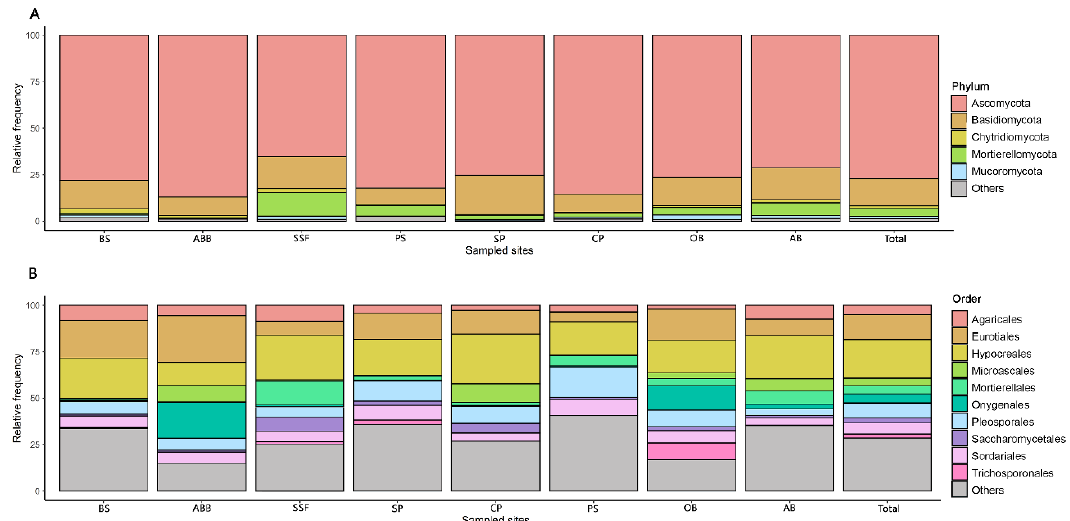
Figure 2. Relative frequency of phylum ( A ) and the ten most abundant orders ( B ) in different environments. BS = Brazilian savanna; ABB = abandoned rural building; SSF = seasonal semi-deciduous forest; PS = pasture; SP = sugarcane plantation; CF = coffee plantation; OB = owls’ burrows; AB = armadillos’ burrows.